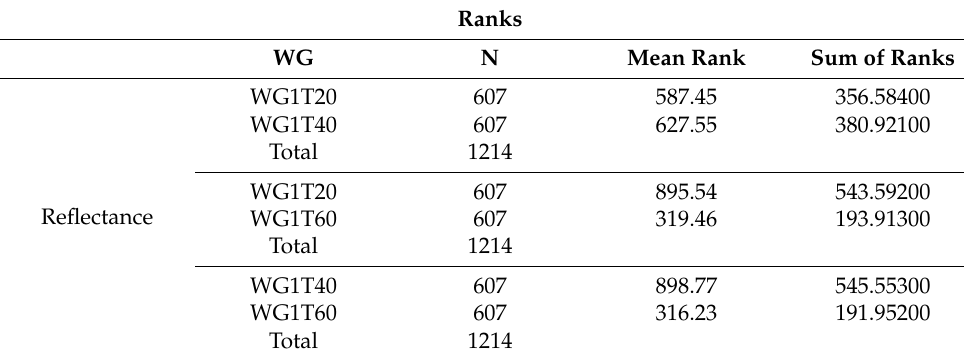
Table A15. Ranks table of Mann–Whitney U test for specular solar reflectance of WG1 during the three holding times.